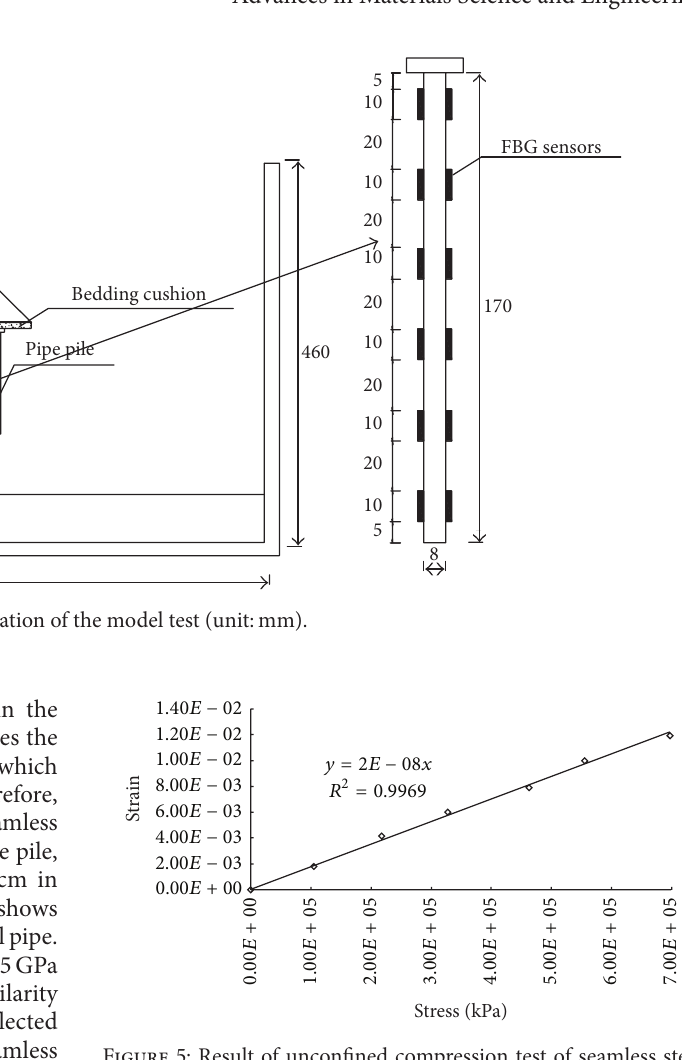
Figure 5: Result of unconfined compression test of seamless steel